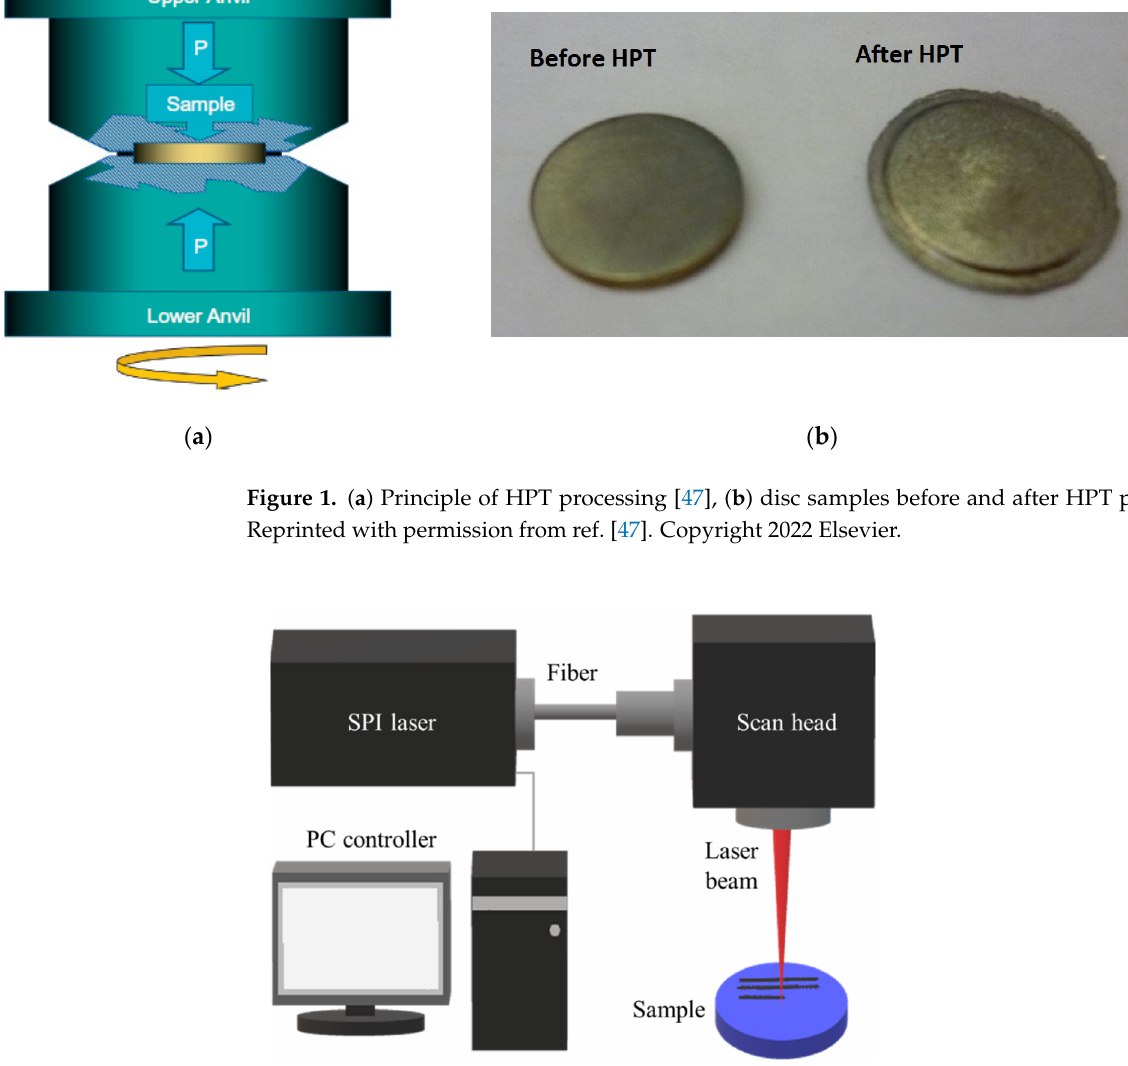
Figure 2. A schematic diagram of the laser system.